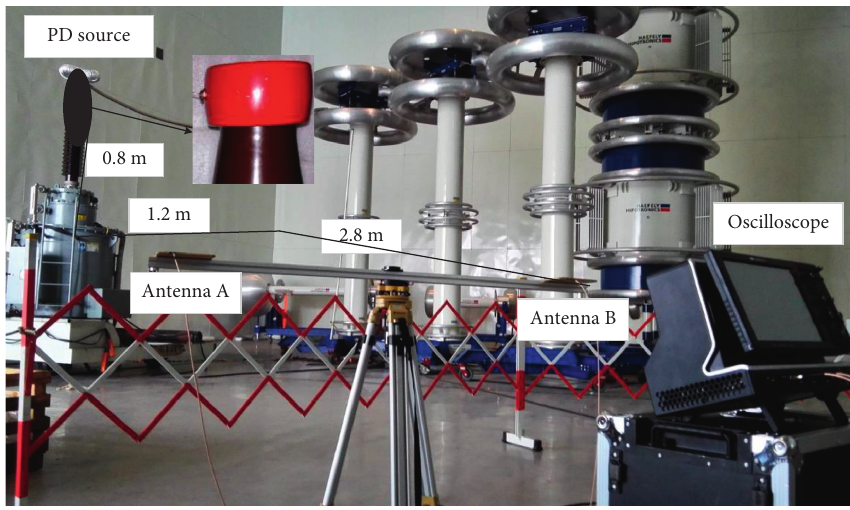
Figure 2: The equipment arrangement of the measurement.